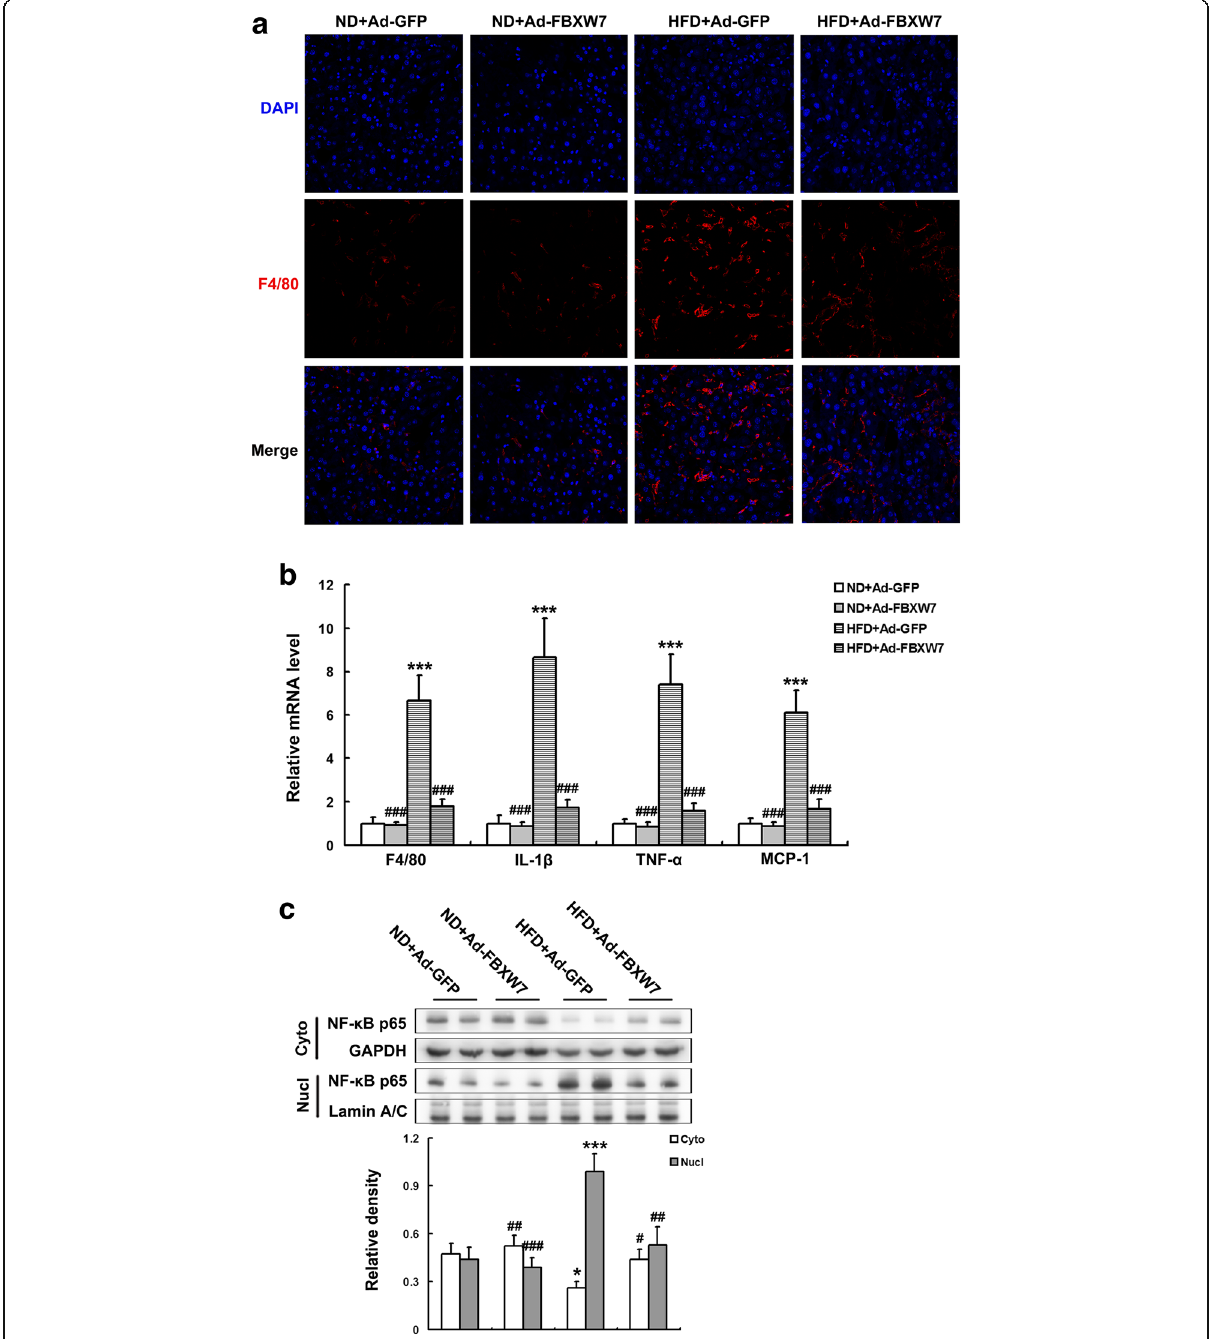
Fig. 3 FBXW7 attenuates inflammatory response in HFD-fed mouse livers. a Representative confocal immunofluorescence images of F4/80 (red) and DAPI (blue) in mouse livers ( n =4). b The mRNA level of inflammation-related genes in mouse livers ( n =3). c Immunoblotting and densitometry of nuclear and cytoplasmic NF- κ B p65 in mouse livers ( n =4). All of the values are expressed as the mean±SD. * P <0.05, *** P <0.001 versus the ND+ Ad-GFP group; # P <0.05, ## P <0.01, ### P <0.001 versus the HFD+Ad-GFP